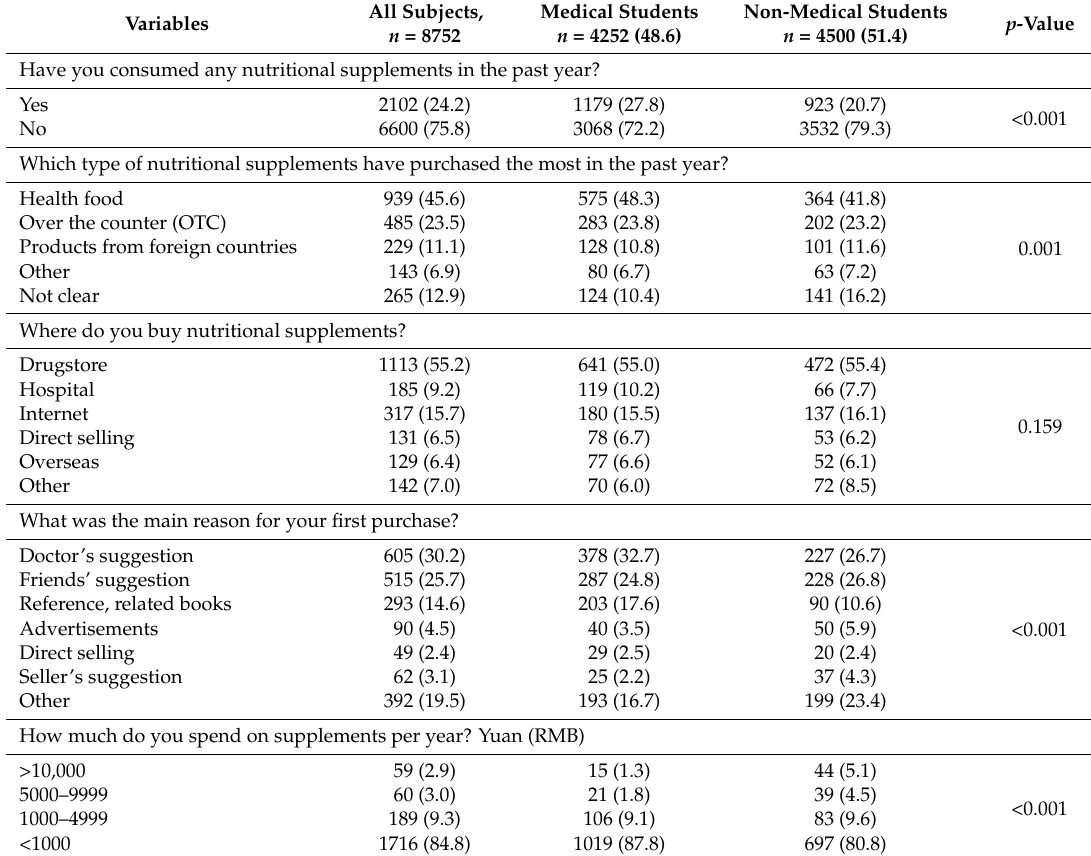
Table 2. Nutritional supplements purchasing behavior